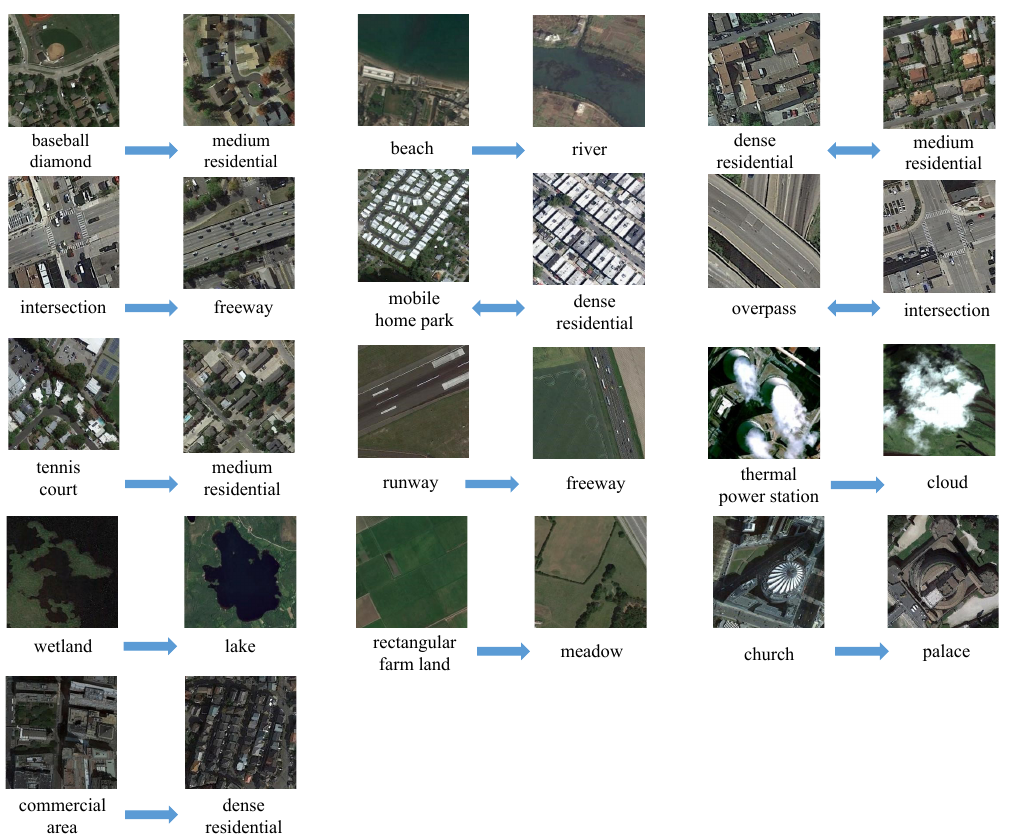
Figure 5. Examples of asymmetric noise mapping scenes in the NWPU-RESISC45 dataset.